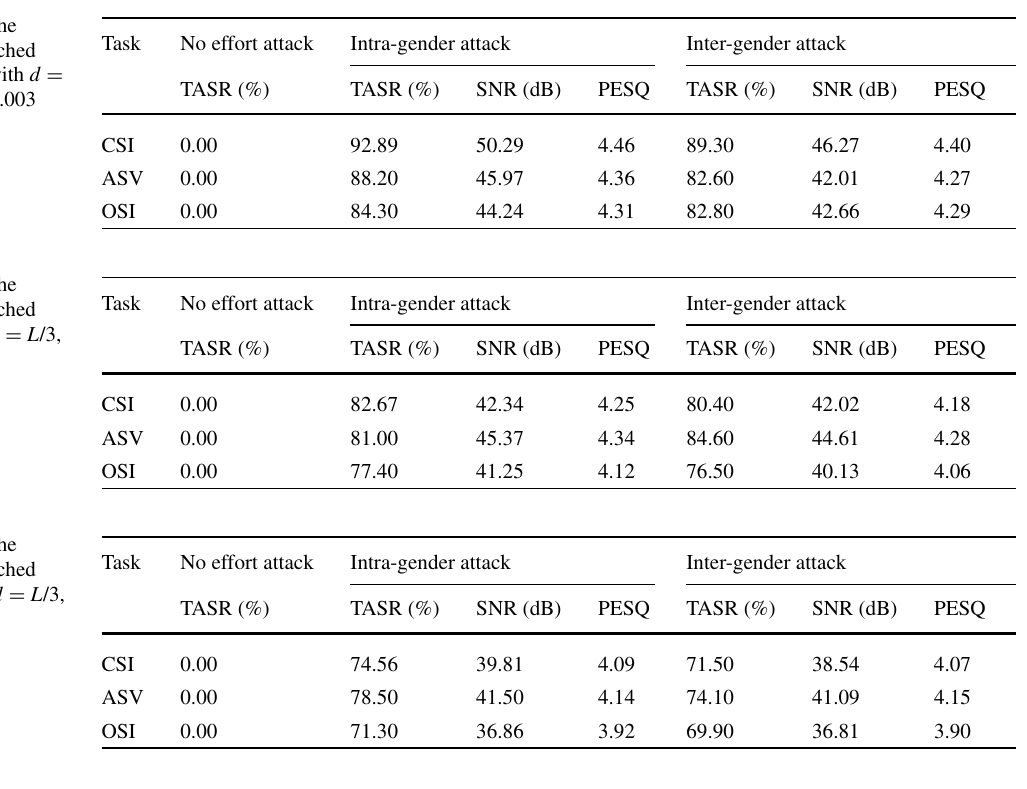
Table 7 Our method w.r.t. recently proposed baselines on matched CSI using x-vector with d (cid:2) L /3, λ (cid:2) 0.005 and ζ (cid:2) 0.003